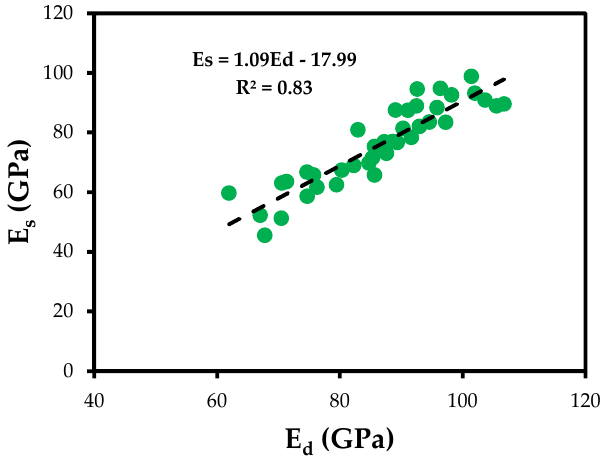
Figure 5. Empirical relationship between E s and E d for prasinites.